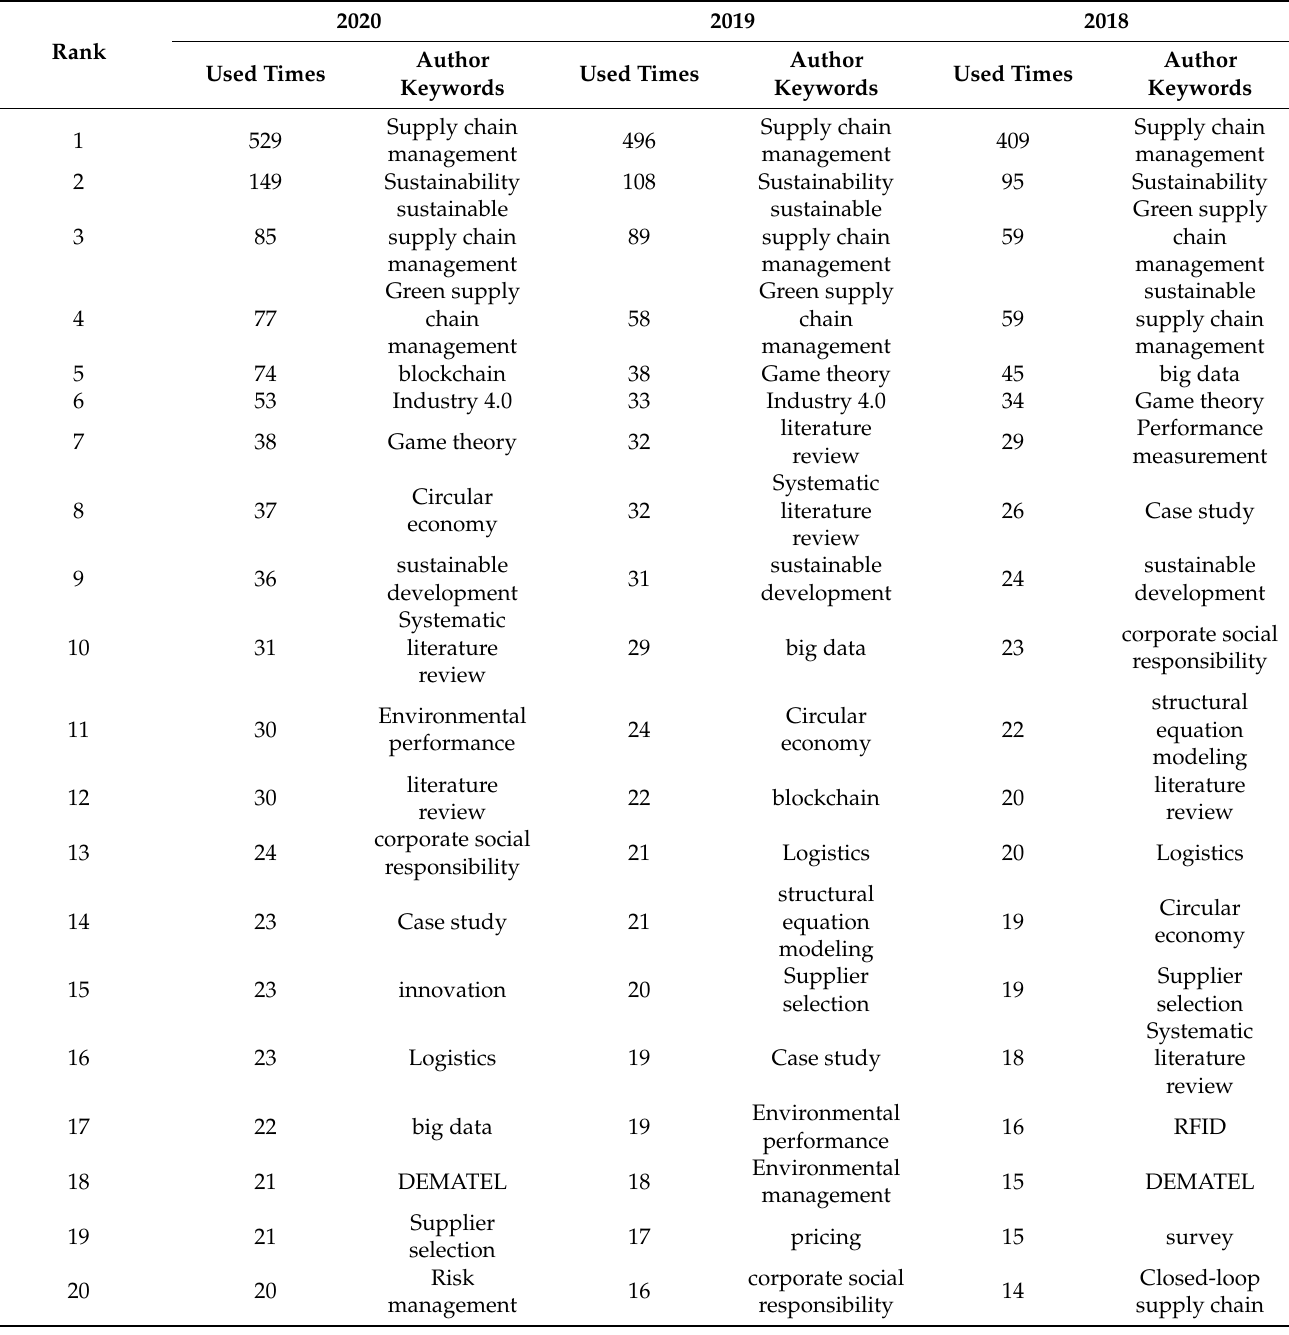
Table 8. Top 20 author keywords in the last three